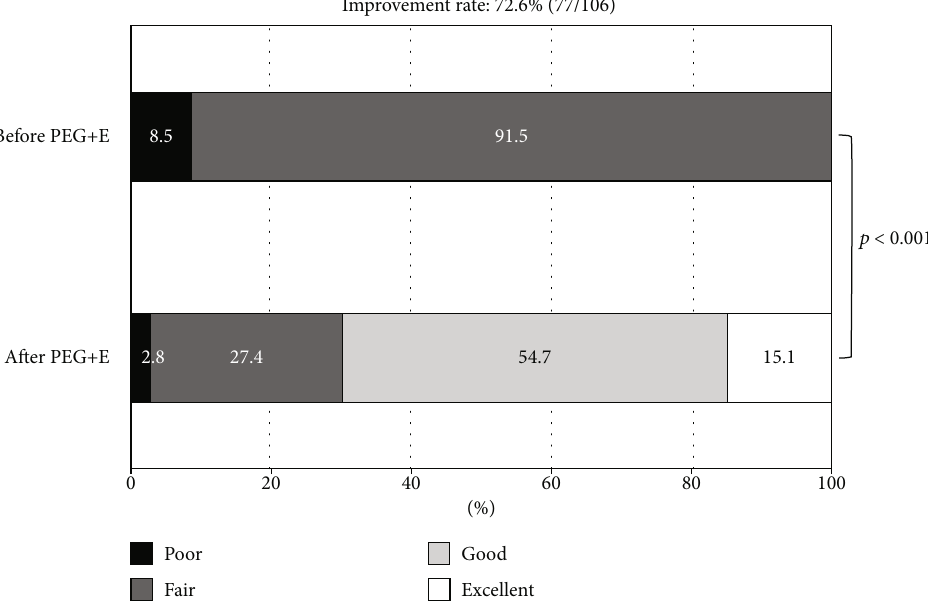
Figure 2: Improvement rate of bowel preparation after prescription of short-duration PEG+E. PEG+E: polyethylene glycol plus